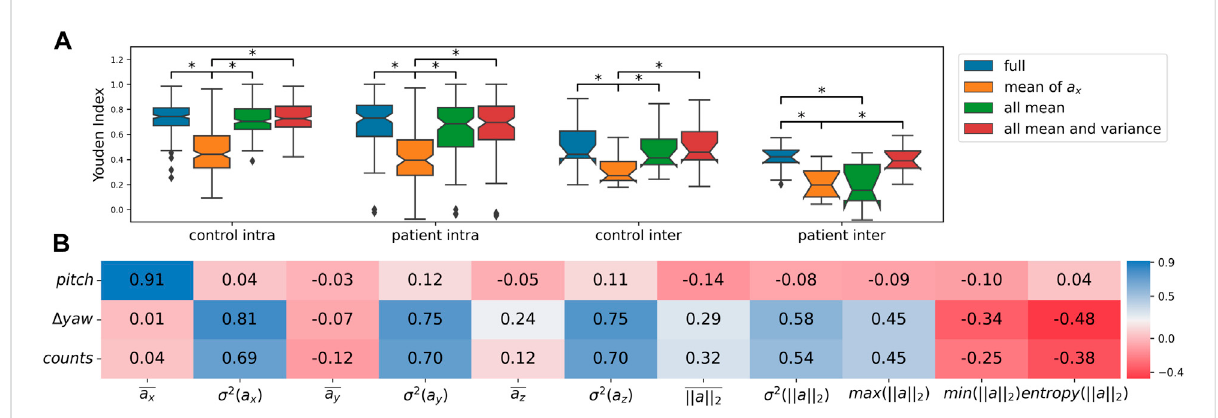
FIGURE 5 (A) Boxplot depicting the Youden indices for the reduced models, *Signi fi cant difference ( p < 0.05); ‘ full ’ refers to models trained with all features — meanandvarianceof a x , a y , a z ,mean,variance,maximum,minimumandentropyof (cid:3) a (cid:3) 2 (11features), ‘ meanof a x ’ aremodelstrainedwith only the one feature, ‘ all mean ’ refers to models trained with mean of a x , a y , a z (3 features), ‘ all mean and variance ’ are models trained with mean and variance of a x , a y , a z (6 features), (B) Correlation coef fi cients between features of the random forest classi fi er and parameters of GM (Gross Movement score) and TAC (Thresholded Activity